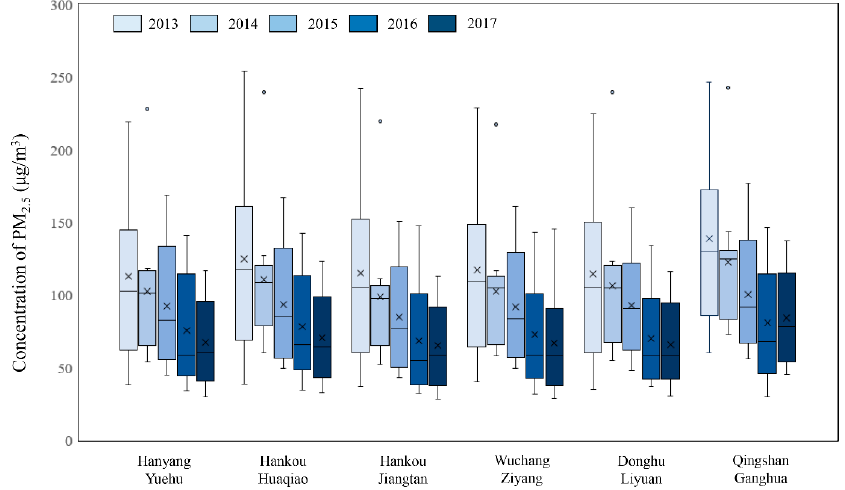
Figure 5. Highest and lowest values of monthly mean PM 2.5 concentration at various monitoring sites during the period of 2013–2017. Table 3. Months with highest and lowest mean monthly PM 2.5 concentration at various stations.